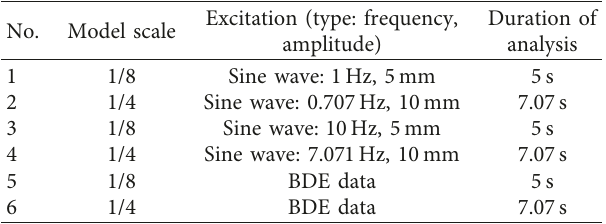
Figure 1: CFD model developed for the spent fuel pool with a scale factor of 1/8. Table 1: Conditions for CFD analysis in the 1/4- and 1/8-scaled models.